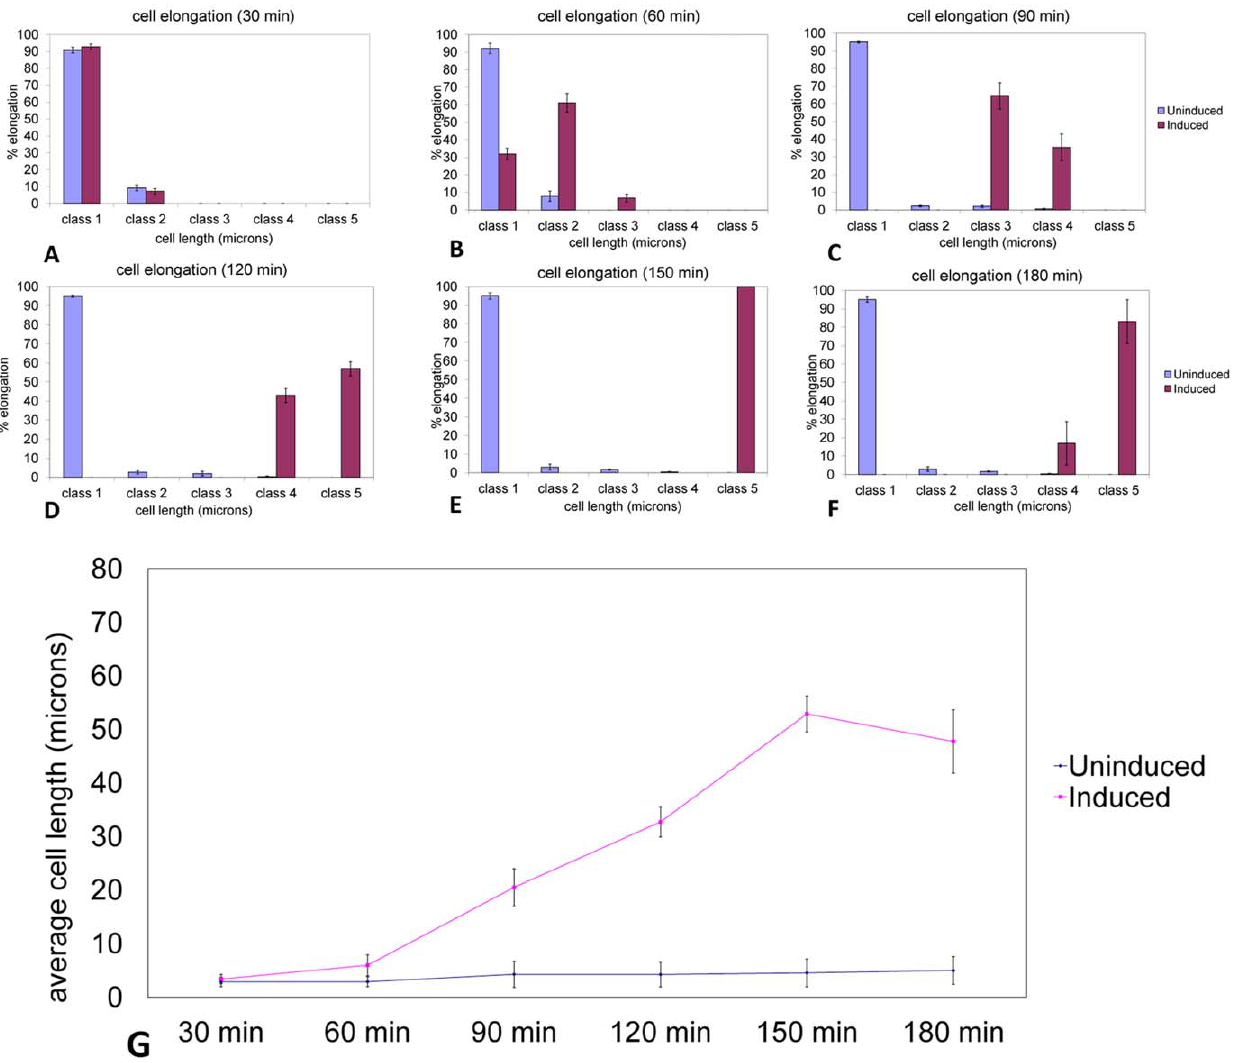
Figure 2. Time course of cell elongation upon continuous exposure to 2 mM IPTG. PB103:pTAK117-minC cells observed at A) 30 min, B) 60 min, C) 90 min, D) 120 min, E) 150 min and F) 180 min post-IPTG exposure. Class sizes are as follows: class 1: 0.5 m m–4 m m, class 2: 4.1 m m–8 m m, class 3: 8.1 m m–16 m m, class 4: 16.1 m m–32 m m, class 5: 32.1 m m–64 m m, class 6: 64.1 m m–132 m m. G. Average cell length versus elapsed time upon constant exposure to 2 mM IPTG . PB103:pTAK117-minC cells observed at different time intervals (30 min, 60 min, 90 min, 120 min, 150 min and 180 min) following continuous IPTG exposure to 2 mM IPTG following which the averaged cell length was plotted with respect to time elapsed post- IPTG